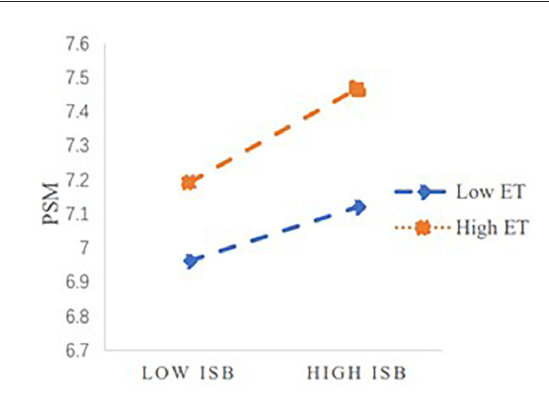
FIGURE2 Moderation effect of emotional trust on the relationship between leaders’ information sharing behavior in the public sector and subordinates’ taking charge behavior.